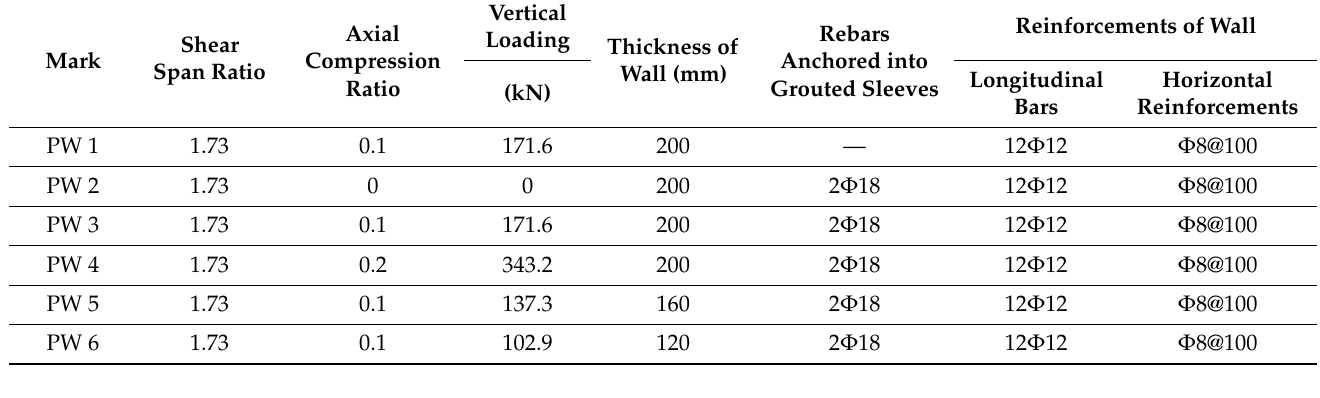
Table 1. Main parameters of PW1–PW6.